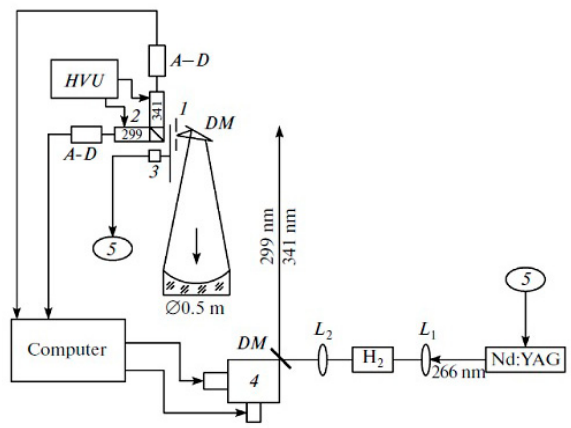
Figure 2. Block diagram of Siberian Lidar Station (SLS) ozone lidar: field diaphragm ( 1 ), cell for spectral selection with a PMT ( 2 ), mechanical shutter ( 3 ), rotating mirrors (RM); automated adjustment unit of an output rotating mirror ( 4 ); solid-state laser (Nd:YAG); SRS conversion cell with H 2 (H 2 ) amplifiers/discriminators (AD)); high-voltage power supply units for the PMT(HSU); lenses (L 1 and L 2 ); system for synchronizing the shutter operation time and the instant of laser pulses emission ( 5 ).